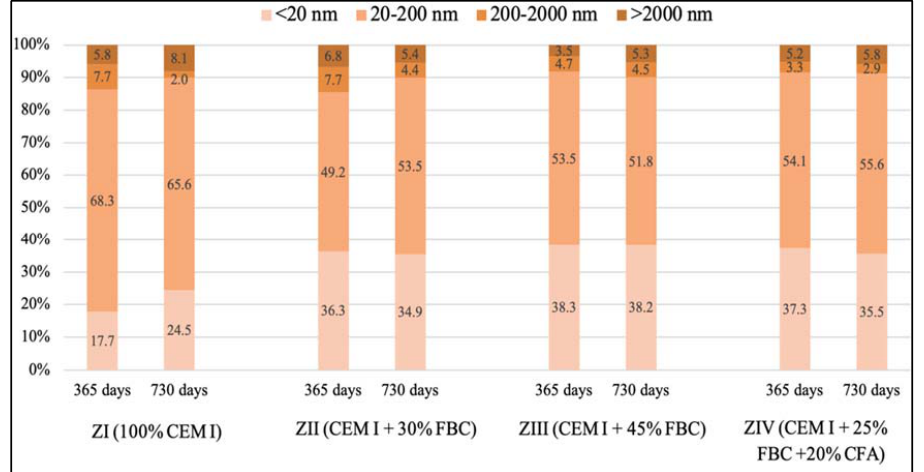
Figure 29. Pore size distribution for the ZI – ZIV mortars stored in water after 365 and 730 days.